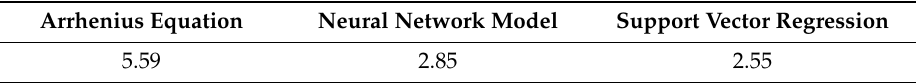
Table 4. Root mean square error using three algorithms.